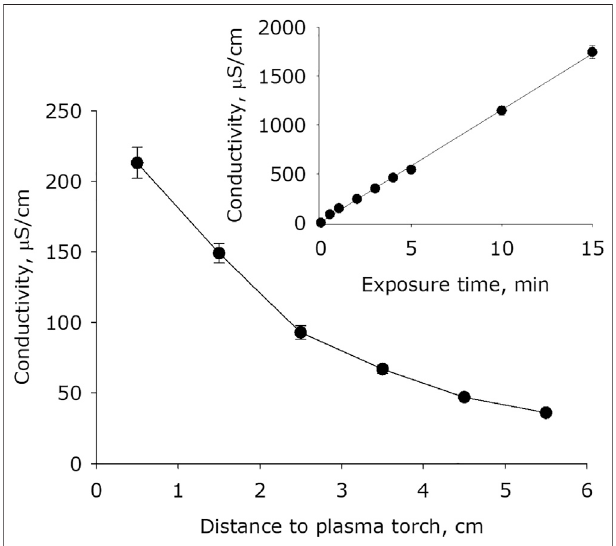
FIGURE 5 | The water redox potential dependence on distance from water surface to the plasma jet nozzle at 1 min of plasma exposure. Data are presented as mean standard error for three independent experiments. Inset shows the water redox potential depending on the time of plasma exposure at 1.5 cm distance from water surface to the plasma jet nozzle. The data are presented as average values with standard deviation of three experiment